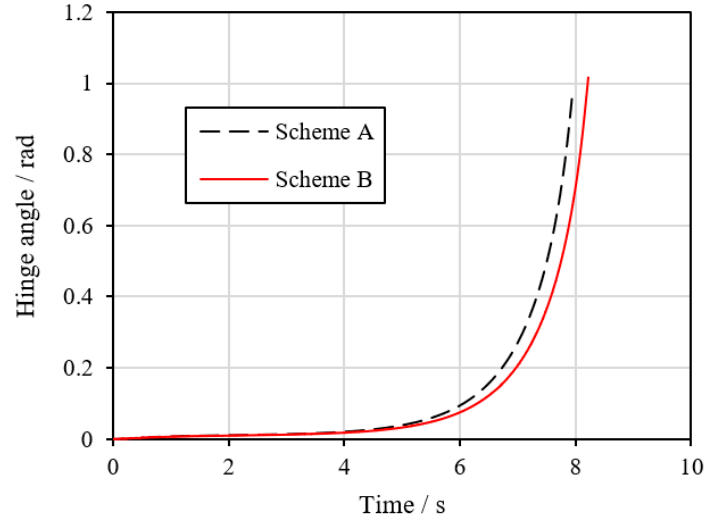
Figure 16. Time histories of hinge II from the FDEM simulations.